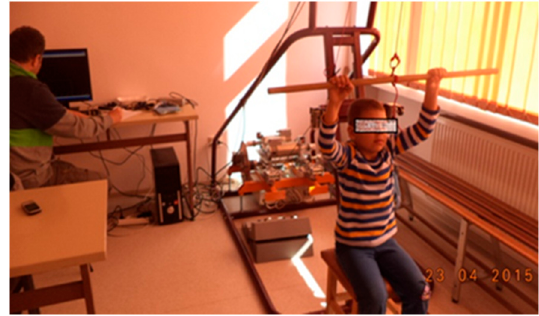
Figure 1. Non-visual execution, ERGOSIM. Initial position: seated at the same time as holding the cane with two hands, grasping from above at shoulder width, arms outstretched. Performing 10 tractions (lowering the cane forward to the abdomen).